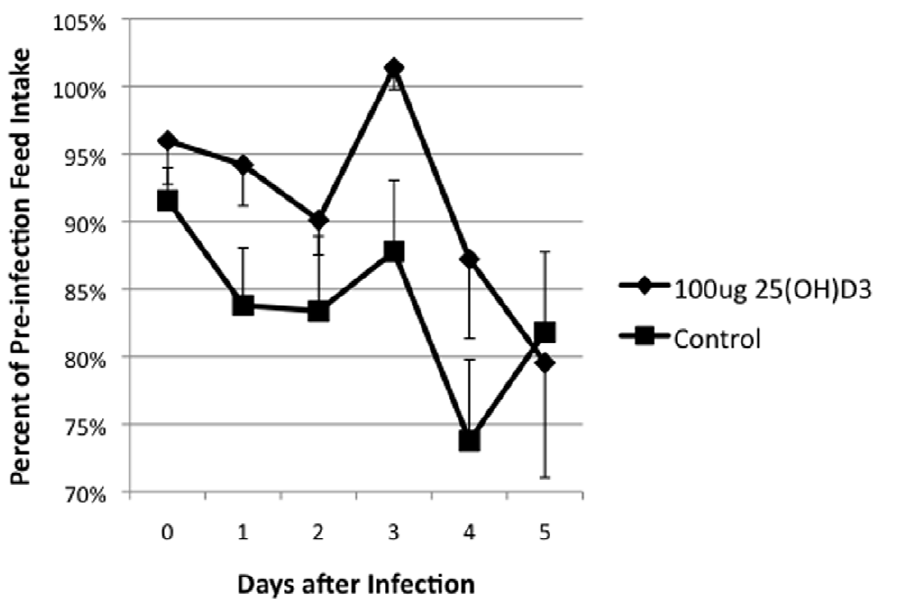
Figure 5. Feed Intake in Control and 25(OH)D 3 Treated Animals. Daily feed intake was determined for each cow. Data are expressed as a percentage of the pre-infections (the average of the 4 days feed intake prior to infection). Each the average was determined for 25(OH)D 3 treated ( u ) and control animals( n ).